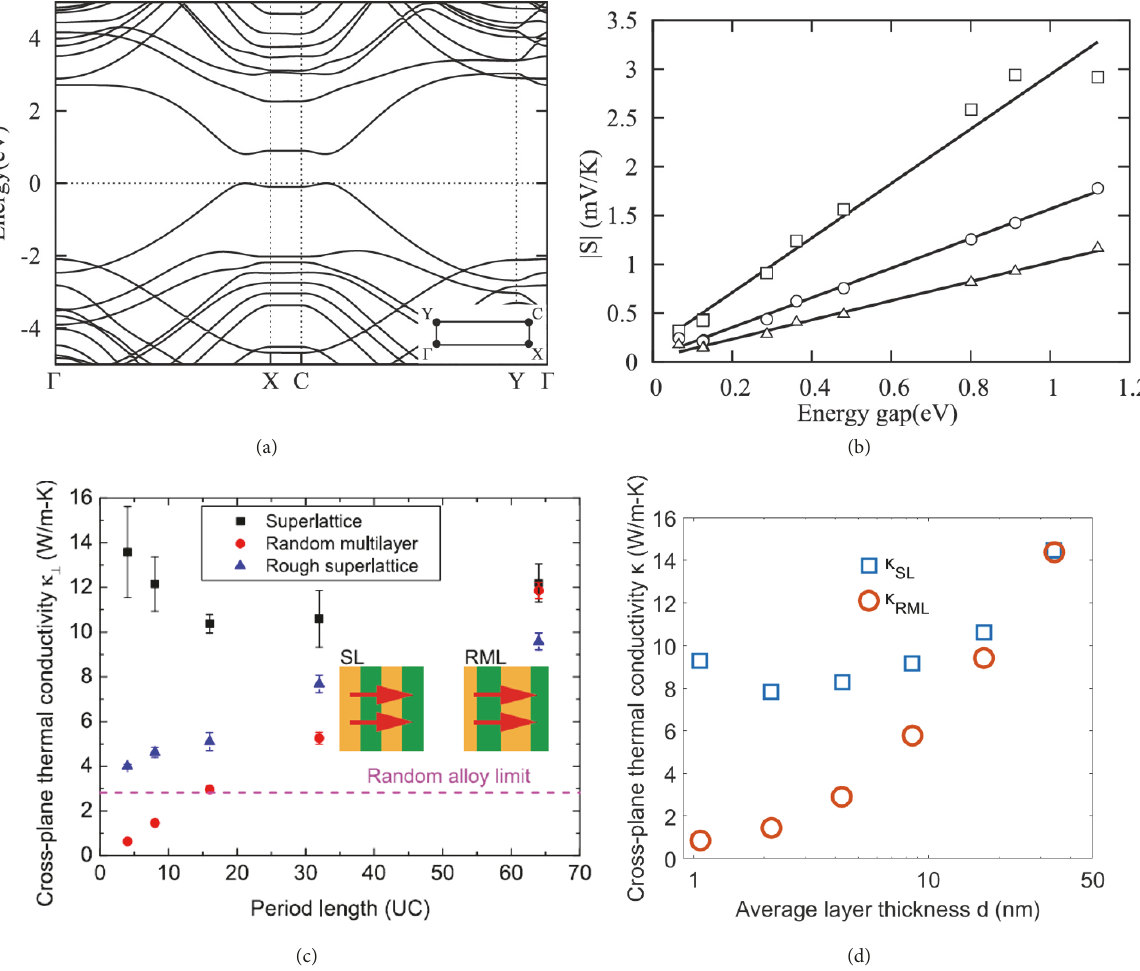
Figure 17: (a) Band structure of a zGNR/zBNNR superlattice consisting of 2 dimer lines of zGNR and 6 dimer lines of zBNNR [176]. (b) Seebeck coefficient as a function of bandgaps for the zGNR/zBNNR superlattices [176]. Squares, circles, and triangles are for 150 K, 300 K, and 450 K, respectively. (c) Cross-plane thermal conductivity of superlattice, random multilayer, rough superlattice, and random alloy for a Lennard-Jones type conceptual crystal [33]. (d) Thermal conductivity of conceptual Lennard-Jones superlattices and random multilayers as a function of average layer thickness [34]. Panels (a)–(c) are reproduced with permission [33,